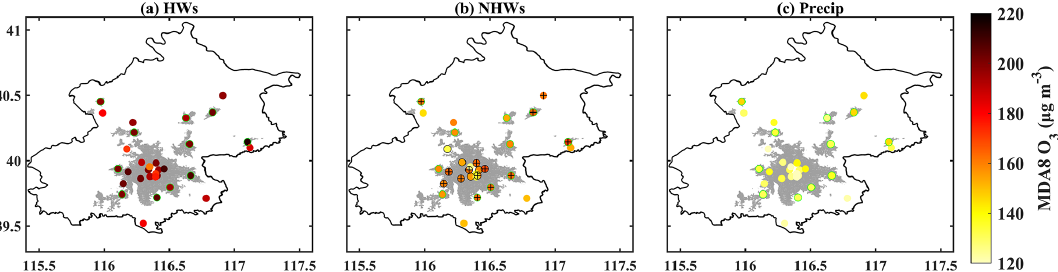
Figure 4. Distribution of MDA8 O 3 under (a) HW, (b) NHW, and (c) precipitation periods (superimposed on built-up area data for 2015; black and green circles represent urban and suburban stations, respectively).